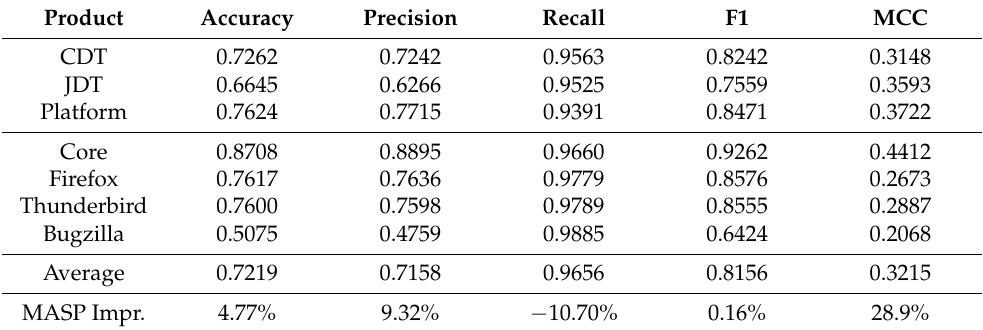
Table 8. Prediction performance of